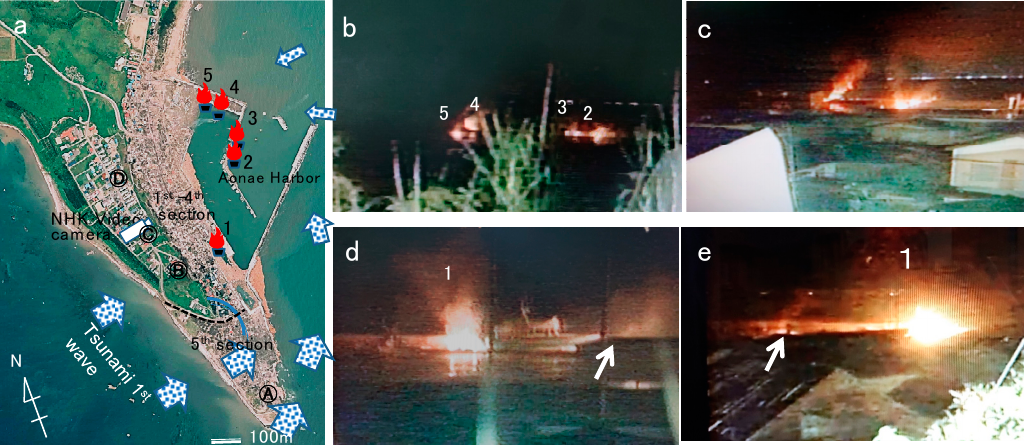
Figure 2. ( a ) Aerial photograph of Aonae district showing the locations of the boat fires that occurred when the first tsunami wave arrived (about 10 min after the mainshock). The photo was taken by the Geospatial Information Authority of Japan (GSI) on July 13, one day after the earthquake. Points Ⓐ – Ⓓ indicate locations where the boat fires were witnessed or recorded by the NHK (Japan Broadcasting Corporation). The numbers 1–5 indicate the boat fires. ( b , c ) Boat fires 2–5. ( d , e ) Two views of boat fire; arrows indicate whitish splashed waves and fiery hot spots, respectively. The source: The “NHK Special” program entitled “ Oo-tsunami ga osotta, Okushiri-t ō karano Houkoku ” (in Japanese), broadcast on July 16, 1993.